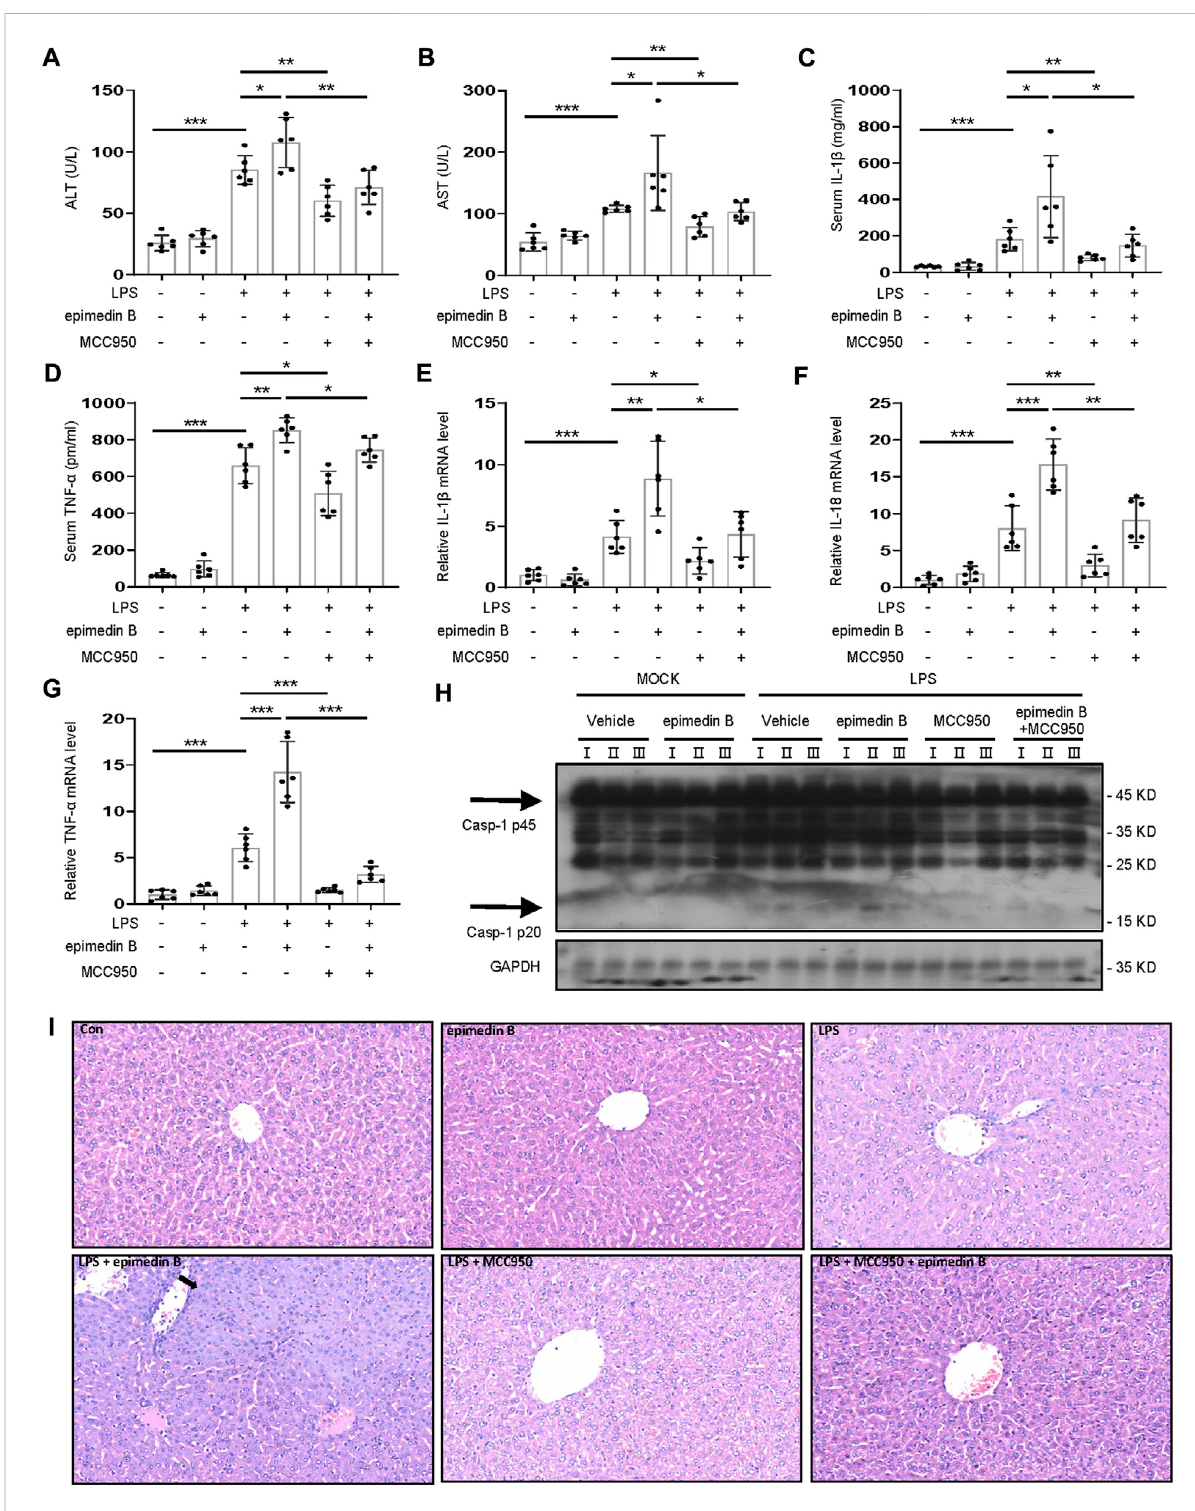
FIGURE 8 Epimedin B induces IDILI by promoting NLRP3 in fl ammasome activation in vivo. (A – I) Female C57BL/6 mice (age: 6 – 8 weeks) were administered MCC950 (40 mg/kg) or its saline vehicle through intraperitoneal injection. After 1 h, lipopolysaccharide (LPS) (2 mg/kg) or its saline vehicle was administered via the tail vein for 2 h. Subsequently, epimedin B (40 mg/kg) was administered via intraperitoneal injection for 6 h (A,B) Serumlevels ofALT (A) andAST (B) ,and (C,D) Serumlevels ofIL-1 β (C) and TNF- α (D) determinedbyELISA. (E – G) PCR ofIL-1 β (E) ,IL-18 (F) ,and TNF- α (G) mRNAlevels. (H) Westernblotanalysisofpro-caspase-1andcleavedcaspase-1expressioninlivertissue. (I) Representativemicrographsof H&Estaining.Data arepresented asthemean±SD.Thesigni fi canceofthedifferences wasanalyzedusingunpairedStudent ’ s t -test:* p < 0.05,** p < 0.01, *** p < 0.001, NS: not signi fi